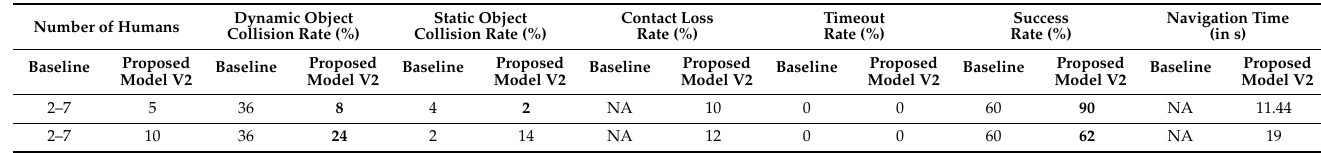
Table 2. Comparison between the baseline model SOADRL [42] and the proposed model V2 with FOV 70 ◦